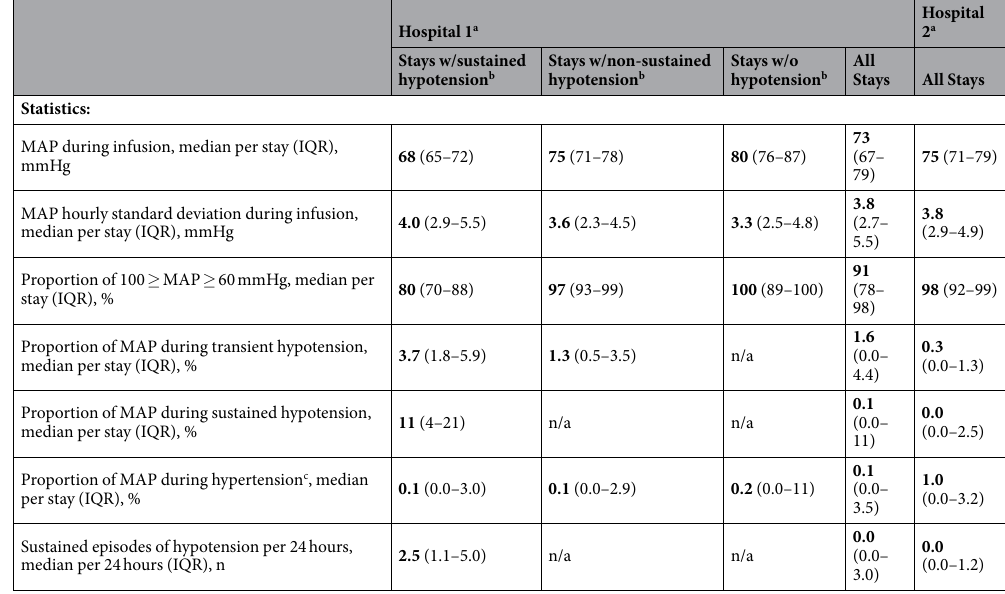
Table 2. Characteristics of MAP during mono-vasopressor infusion. a Hospital 1 includes patient data from the MIMIC II database and Hospital 2 includes patient data from a separate medical center. b Hypotension is defined as MAP < 60 mmHg and sustained episode of hypotension is defined as ≥ 15 min; see text for details. c Hypertension defined as MAP > 100